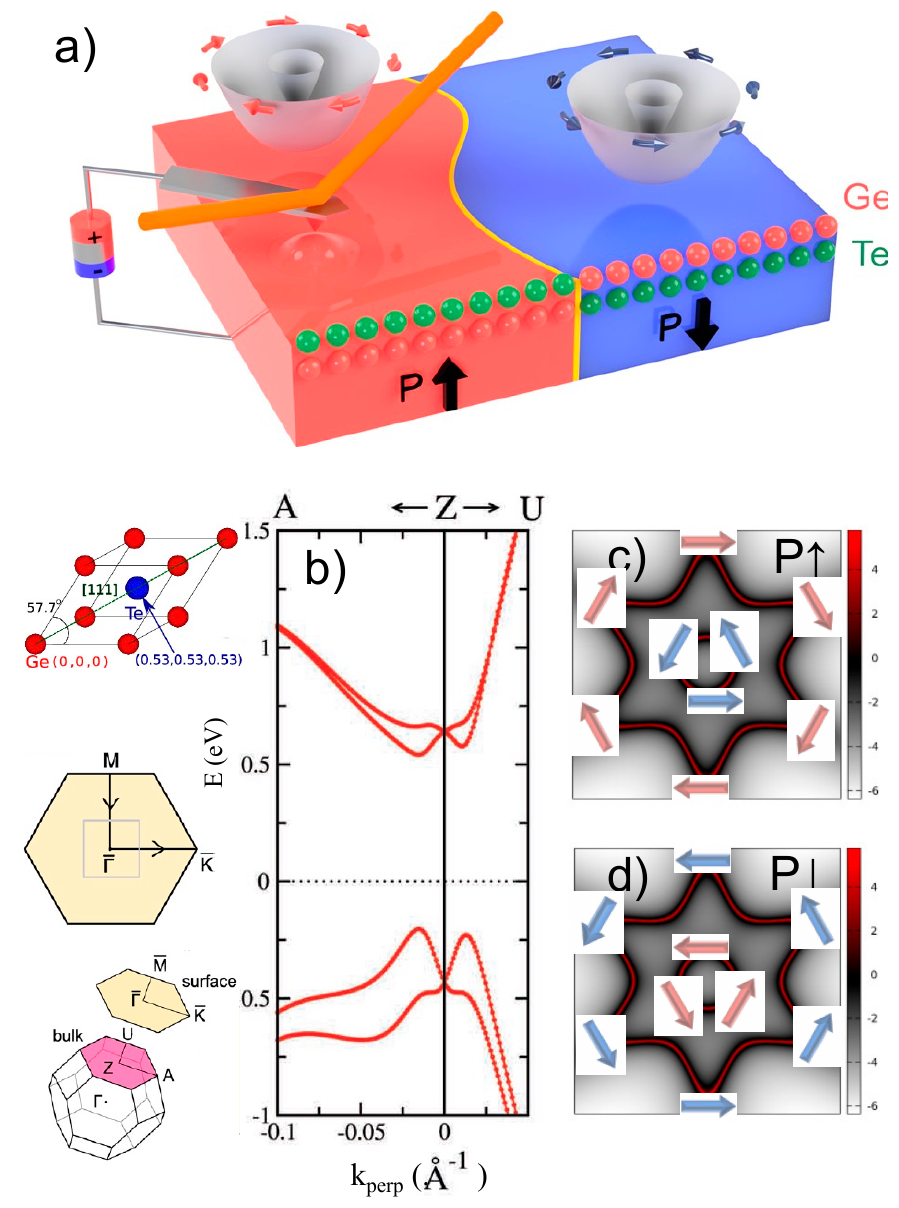
Figure 2. ( a ) FERSC concept, based on the link between polarization and spin texture: for polarization pointing “up” (“down”), i.e., P ↑ (P ↓ ), the spin expectation value in the outer branch of the Rashba bands is circulating clockwise (counterclockwise), whereas in the inner branch it is circulating counterclockwise (clockwise). Reprinted with permission from Ref. [88]. Copyright © 2022 American Chemical Society. ( b ) GeTe band structure, calculated via DFT, in the two directions Z-A and Z-U for the highest valence band and lowest conduction band. In the left column, the GeTe rhombohedral crystal structure is shown along with the bulk Brillouin zone and its projection on the experimentally most stable surface. A squared zoom is also shown around the bulk Z-point (corresponding to the Γ point on the surface), lying in a plane perpendicular to the polarization direction (in reciprocal space). ( c ) isoenergy cut at around − 0.5 eV for polarization pointing “up”, plotted in the abovementioned square around the Z-point. The arrows denote the spintexture of the inner and outer Rashba bands. ( d ) same as ( c ) but for polarization pointing “down”. COPYRIGHT: panel ( a ). Reprinted with permission from Ref. [84]. Copyright © 2022 John Wiley and Sons, Inc.